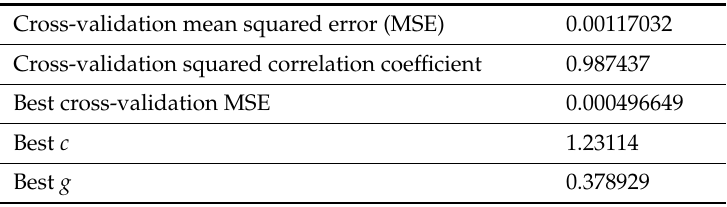
Table 3. Final result of fine selection.